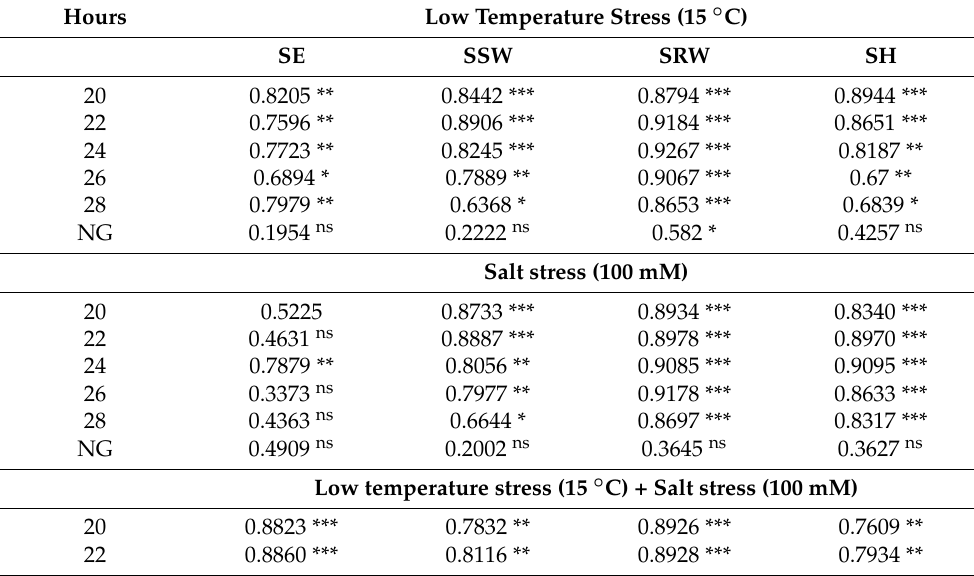
Table 5. Correlation coefficient values (r) for hybrid cucumber lots between RE after 20, 22, 24, 26 and 28 h at 25 ◦ C, NG and their seedling emergence (SE, %), seedling shoot weight (SSW, mg), seedling root weight (SRW, mg), seedling height (SH, cm) at low temperature, salt and combination